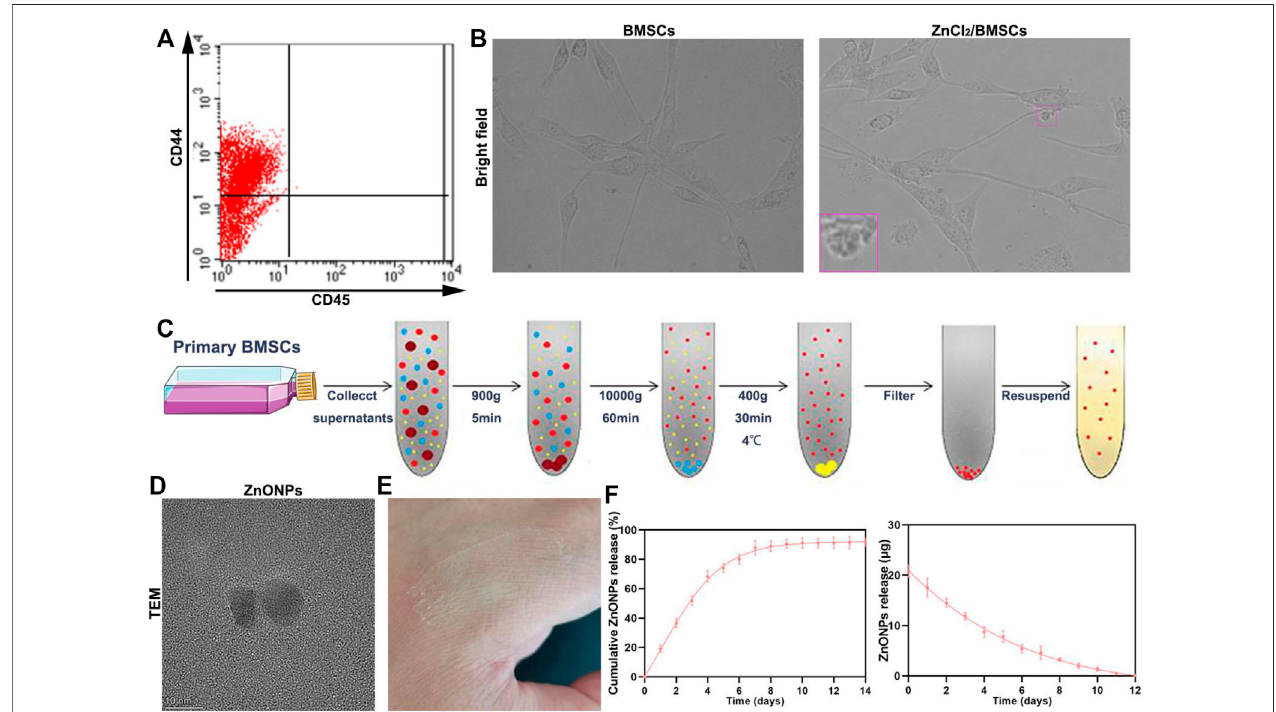
FIGURE 1 | Fabrication characterization of ZnONP-loaded hydrogels. Flow cytometry of primary BMSCs (A) . Representative images of BMSCs (B) . Scheme of stepsforextractingBMSCs (D) .RepresentativeimageofZnONPs (D) .RepresentativeimageofZnONP-loadedhydrogelsolidi fi cation (E) .Representativequanti fi cations of ZnONP release (F – G) in ZnONPs-Gel. Data are mean ± SD ( n (cid:2) 3).